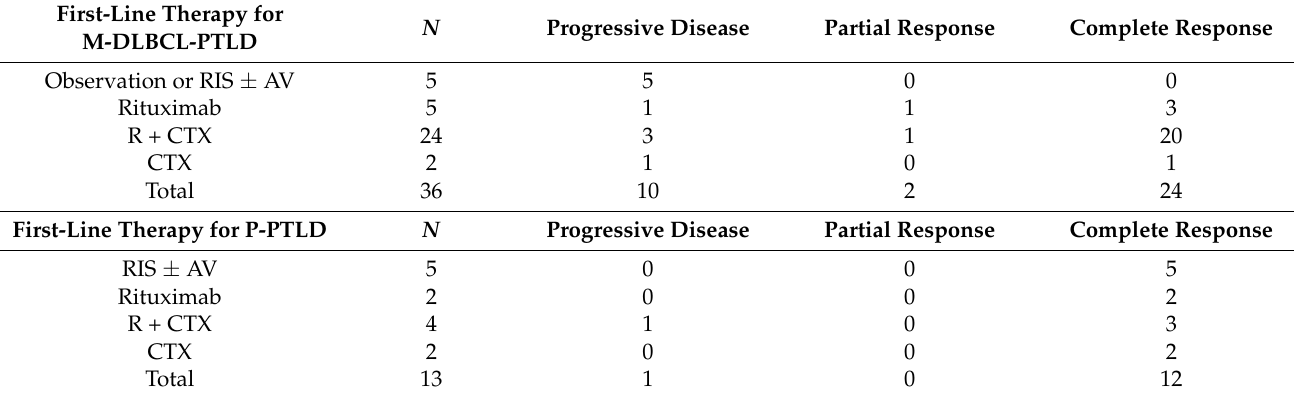
Table 3. Treatment Strategy and Outcome for M-DLBCL-PTLD and P-PTLD Subtypes. First-Line Therapy for N Progressive Disease Partial Response Complete M-DLBCL-PTLD